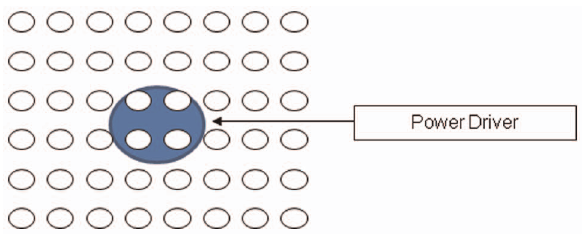
Figure 1. Schematic of 48-well plates connected to the piezo ceramic element. The element is attached to the bottom of the plate as depicted in the oval and is connected to an electronic driver powered by a 3.5 V